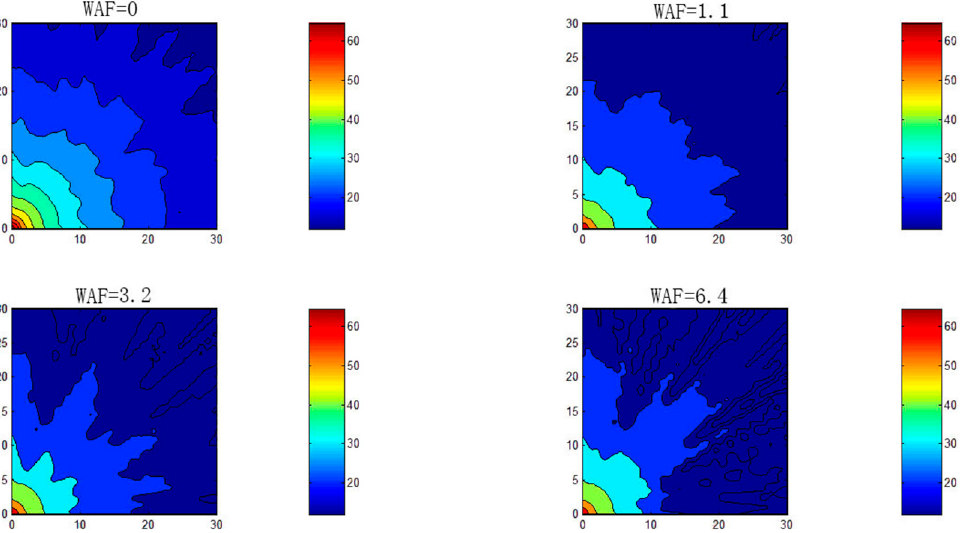
Figure 4. Crowd effects with one AP.